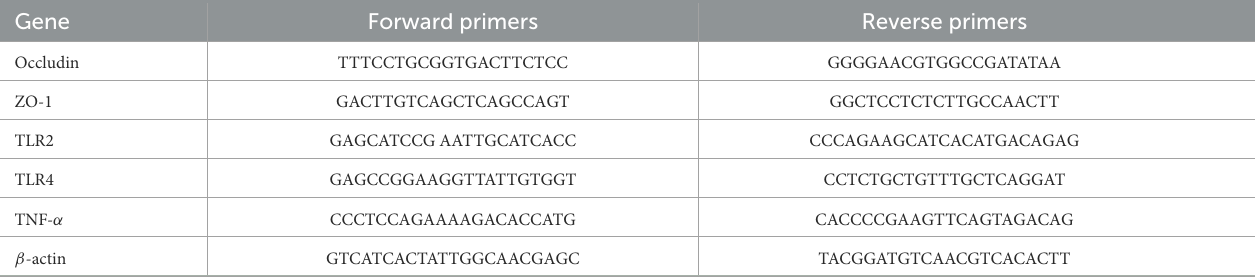
TABLE 2 The primer sequences for